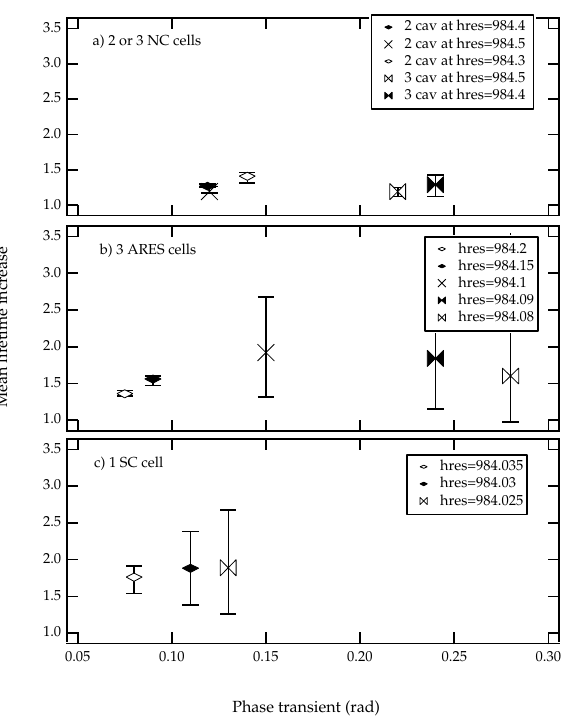
FIG. 8. Lifetime improvement versus total bunch synchronous phase transient computed for various operational conditions with passive harmonic cavities on the ALS ring with a 17% gap at 400 mA. The error bars indicate the range of variation along the bunch train. (a) Two and three NC cavities. (b) Three ARES-type structures and (c) one SC